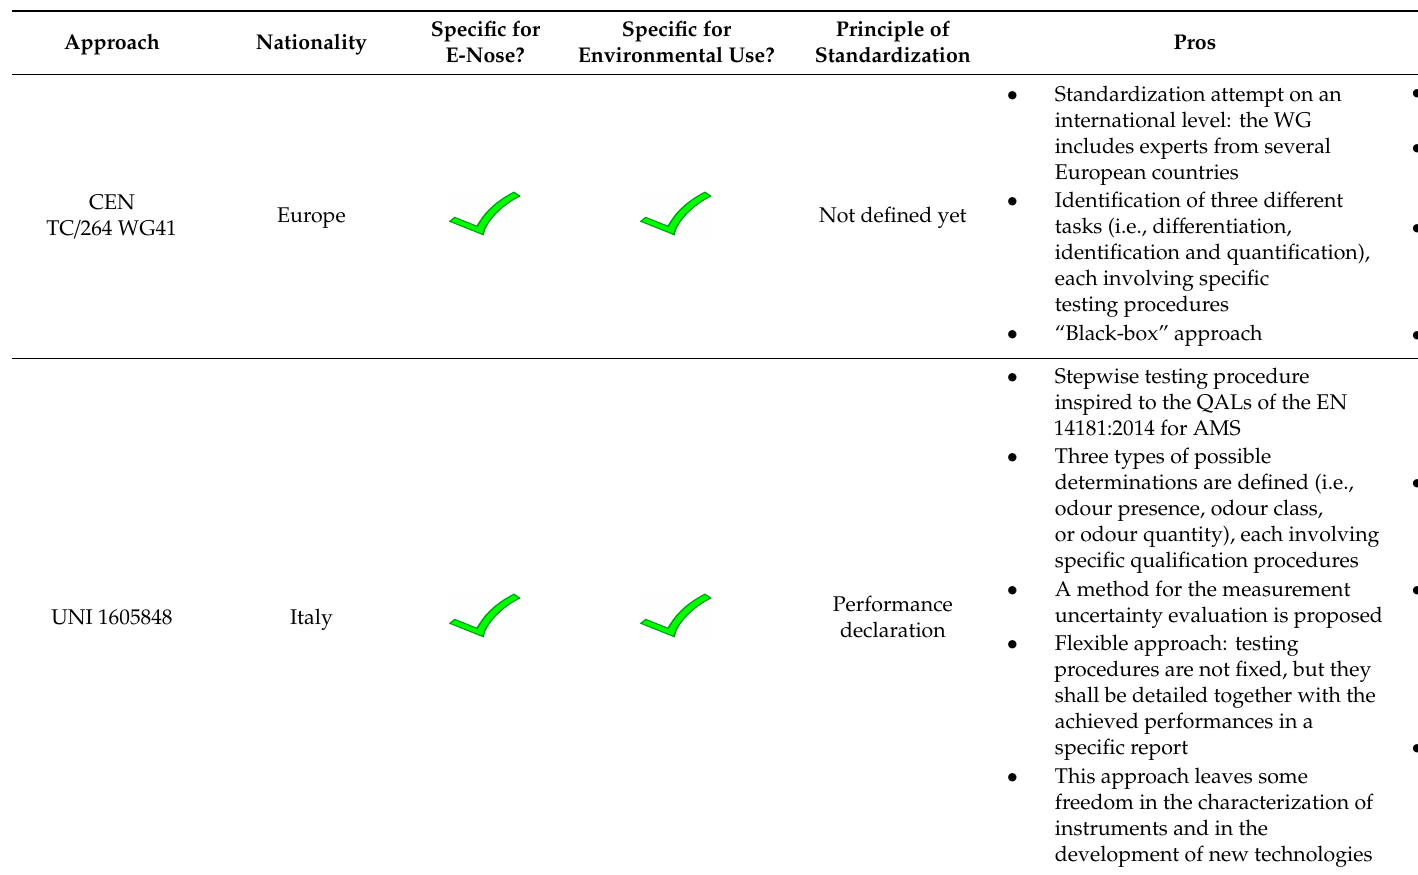
Table 1. Schematization of the existing approaches that can be applied for e-nose qualification and standardization in environmental odour monitoring applications. Approach